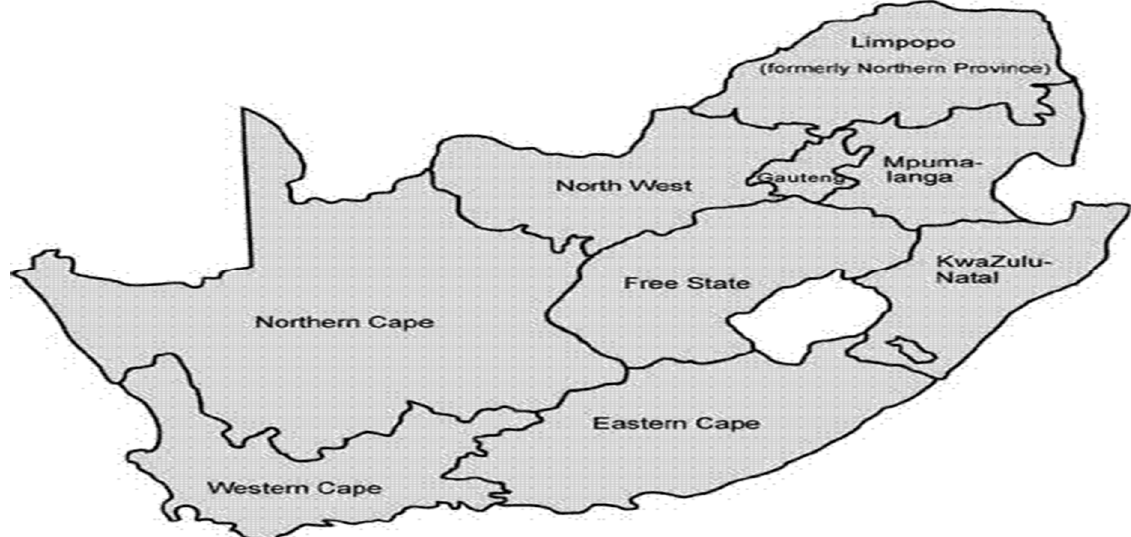
Figure 1. Map of South Africa.